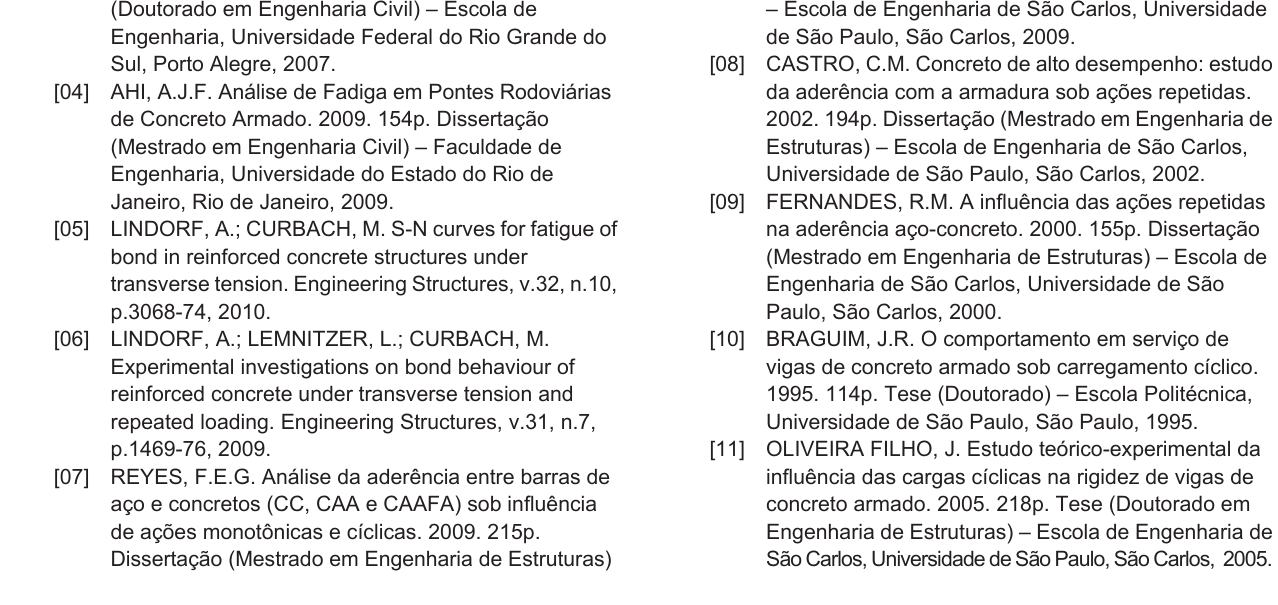
Table 6 – Percentual variation of maximum deflections: theoretical and experimental results